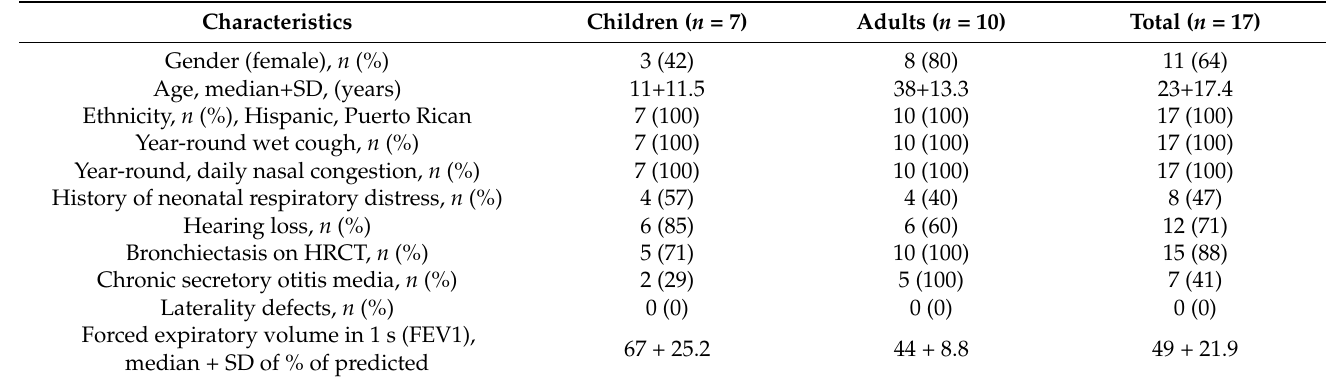
Table 3. Clinical characteristics and demographics of homozygous subjects for the RSPH4A (c.921+3_6delAAGT) founder